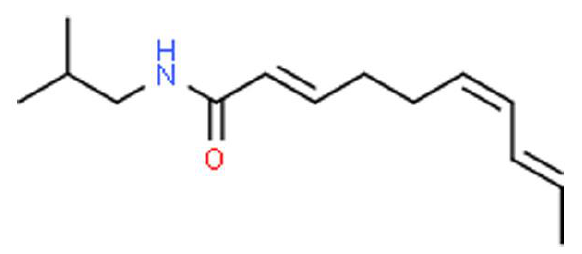
Figure 2. The chemical structure of Spilanthol.